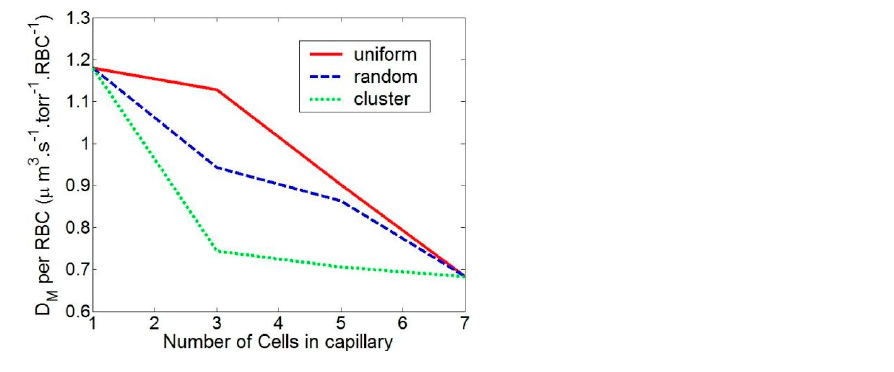
Figure 8. Average diffusion capacity per RBC for different RBC distribution and Hematocrit.